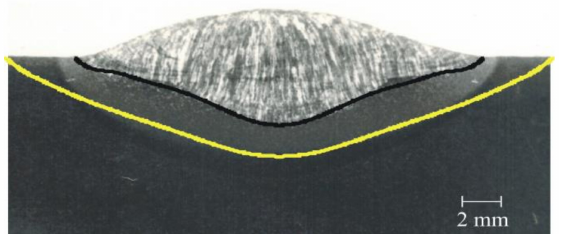
Figure 16. Metallographic specimen with comparison of calculation and experiment